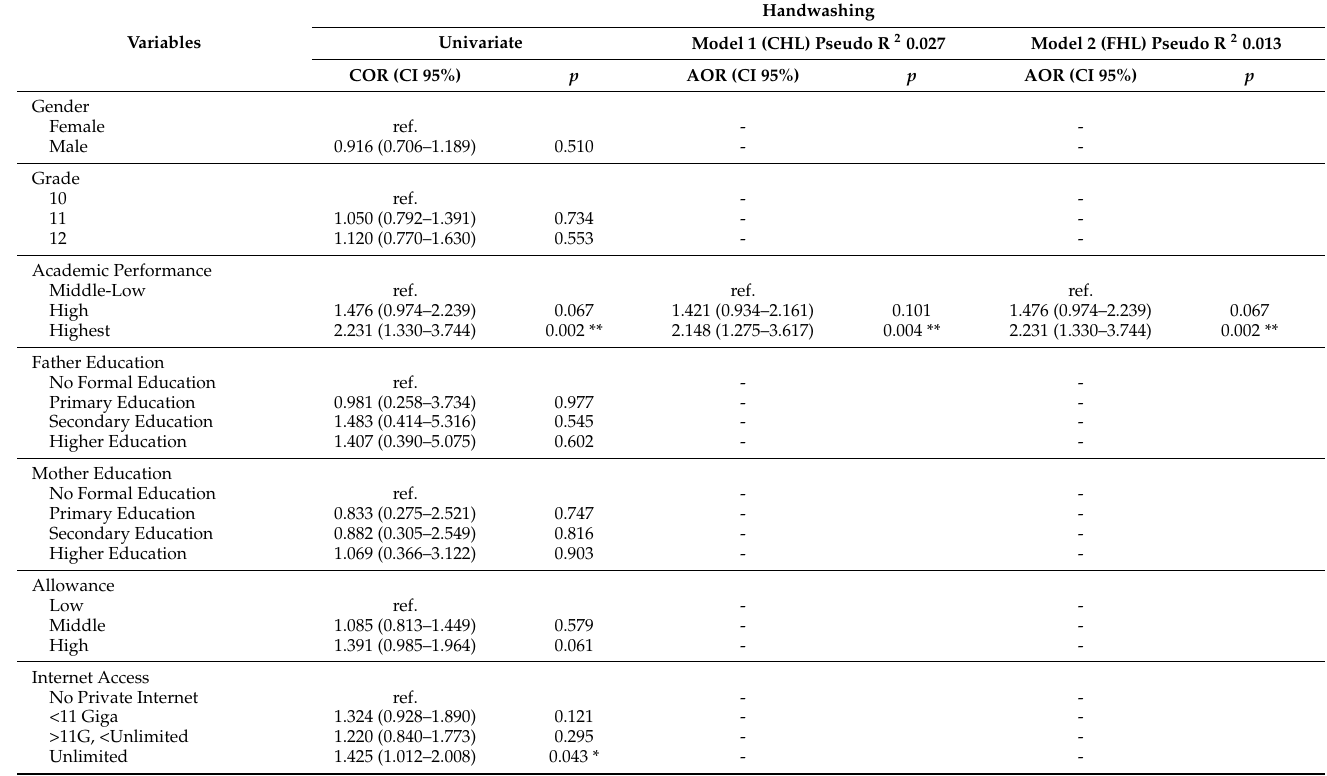
Table 4. Univariate and multivariate logistic regression of handwashing with socioeconomic factors in the CHL and FHL